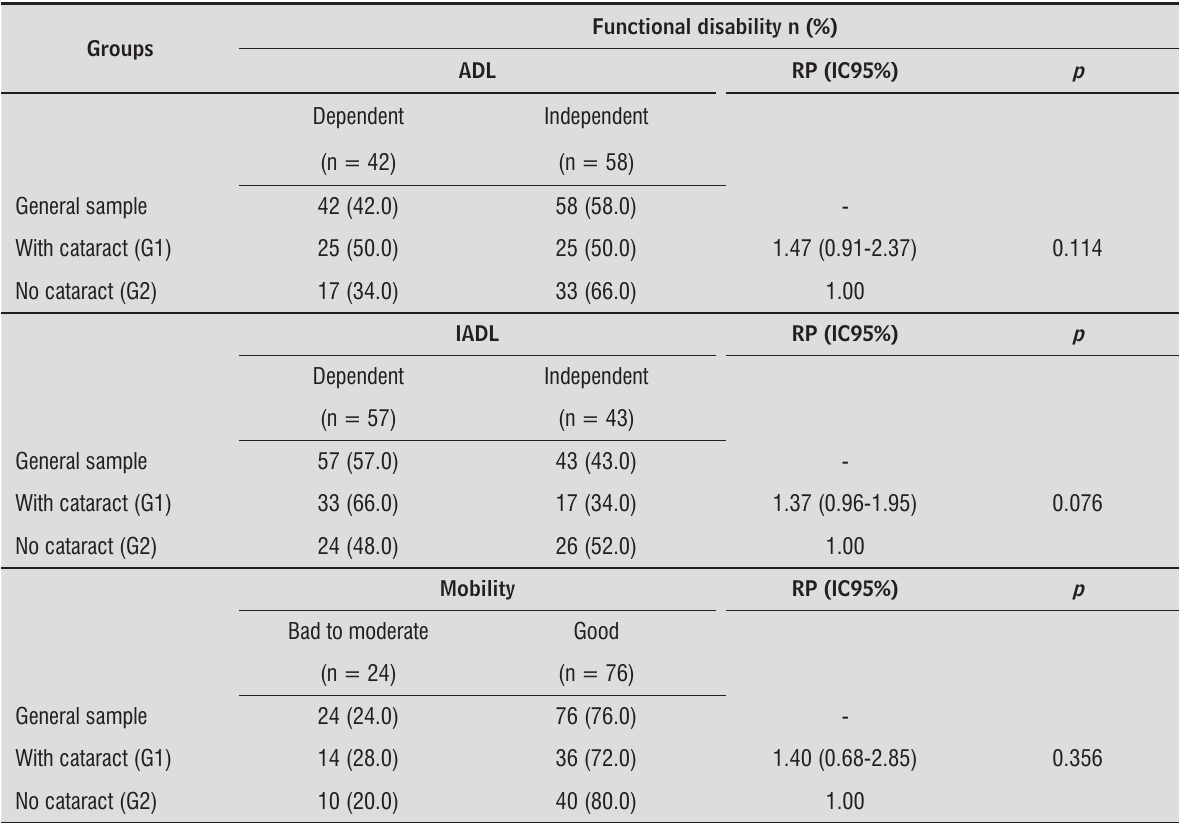
Table 2 - Prevalence of functional disability (ADL, IADL, and mobility) in the general sample and in the elderly with and without cataract